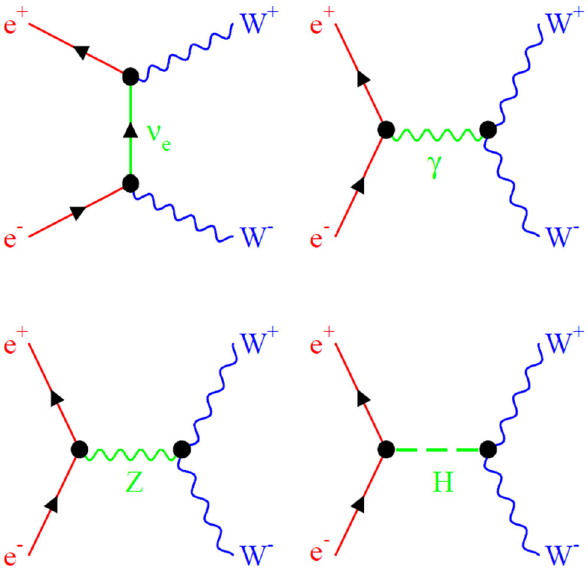
Fig. 1 The leading-order Feynman diagrams of W + W − production in e + e − collisions. The last one is neglected in this study since it is highly suppressed due to the small electron (positron)